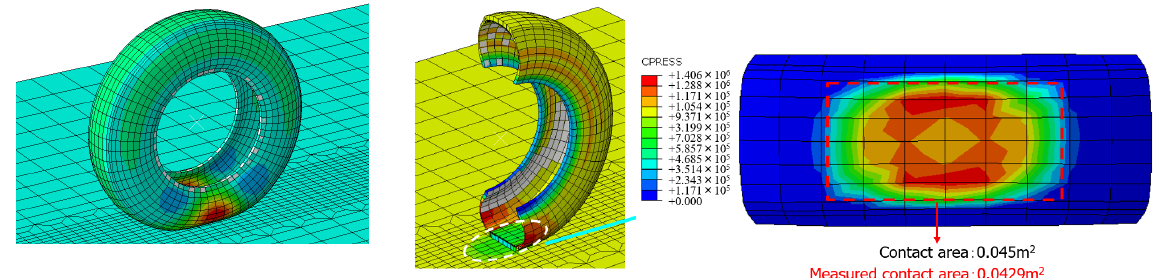
Figure 8. Tire ground pressure of ART vehicle.